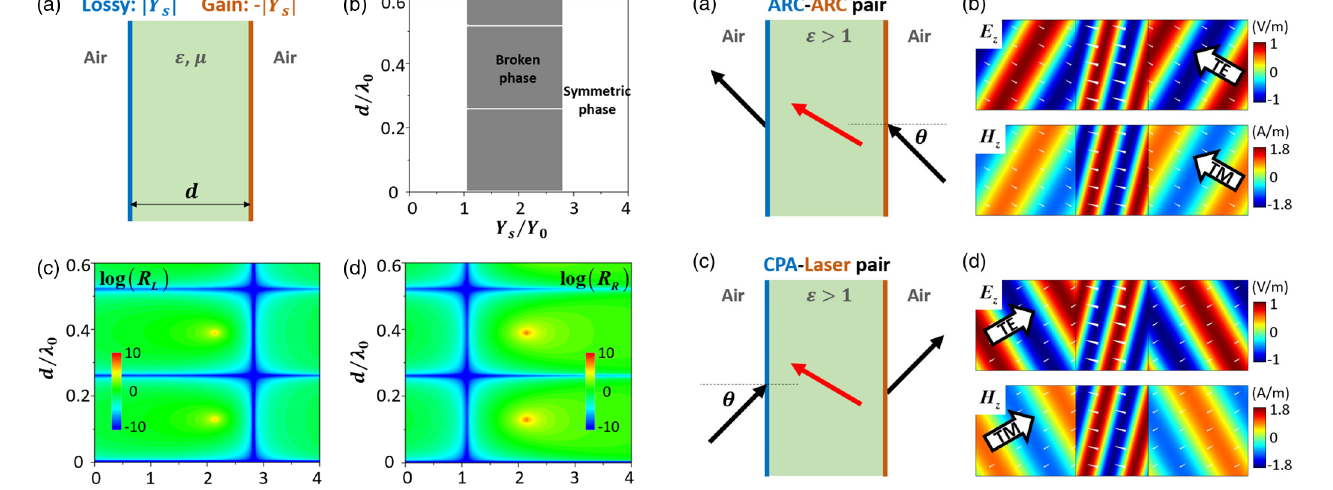
FIG. 2. (a) Illustration of the positive refraction in an ARC- ARC pair associated with the lower EP under the right incidence. (b) Simulated electric or magnetic fields: E z (TE polarization, Y ¼ 1 . 07 Y H Y ¼ 0 . 91 Y s 0 ) or z (TM polarization, s 0 ), and the time-averaged power flow (arrows) for the model in panel (a). (c) Illustration of the negative refraction in a CPA-laser pair associated with the upper EP under the left incidence. (d) Simu- lated electric or magnetic fields: E z (TE polarization, Y ¼ 2 . 80 Y H Y ¼ 3 . 22 Y s 0 ) or z (TM polarization, s 0 ), and the time-averaged power flow (arrows) for the model in panel (c). The incident angle in panels (b) and (d) is θ ¼ 30